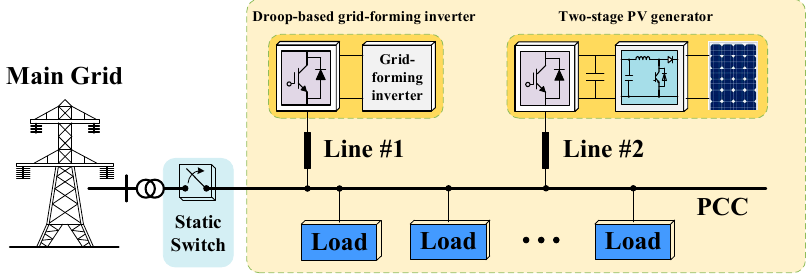
Figure 9. Diagram of the studied islanded micro-grid.